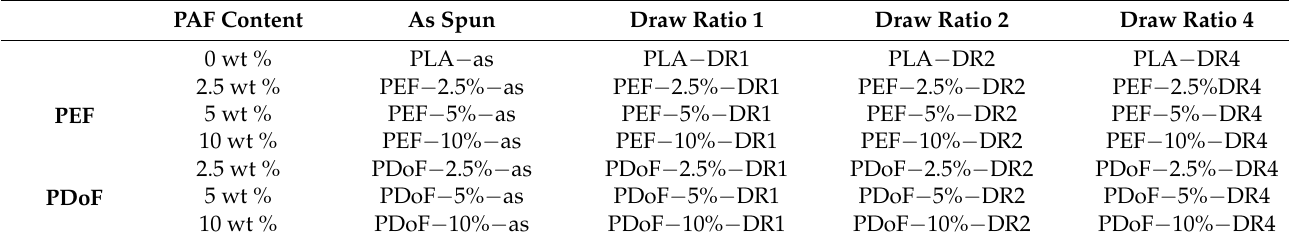
Table 1. List of the prepared samples with their nominal weight